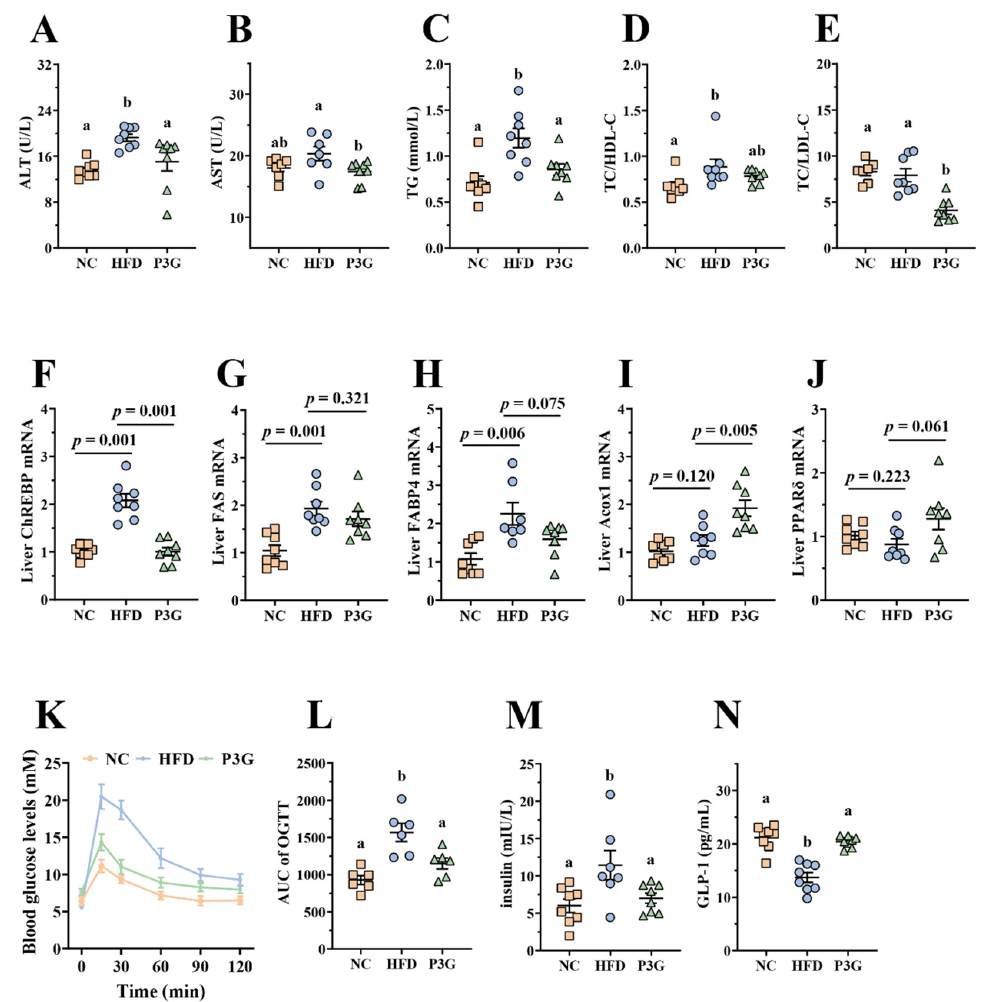
Figure 2. P3G supplementation alleviated HFD-induced glycolipids metabolism disruption in mice. ( A ) ALT, ( B ) AST, ( C ) TG, ( D ) TC/HDL-C, and ( E ) TC/DLD-C levels in plasma. ( F – J ) ChREBP, FAS, FABP4, Acox1, and PPAR δ mRNA levels in liver, respectively. ( K ) Blood glucose and ( L ) area under the curve (AUC). ( M ) Plasma insulin level. ( N ) Plasma GLP-1. Data are expressed as mean ± standard error (mean ± SEM) and analyzed using one-way analysis of variance (ANOVA); a and b represent significant differences between groups. The same letter indicates no significance between the two groups, and different letters indicate significance ( p < 0.05).